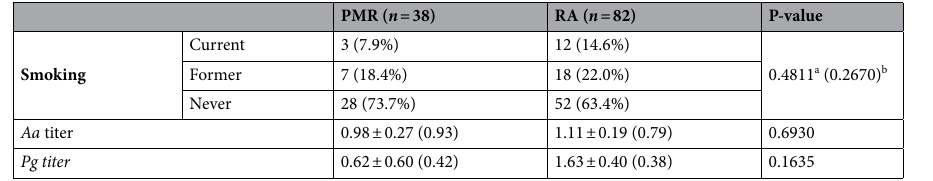
Table 2. Serum IgG antibody titers of patients with PMR and RA. Data are expressed as means ± SE (median). Aa Aggregatibacter actinomycetemcomitans , IgG immunoglobulin G, Pg Porphyromonas gingivalis , PMR polymyalgia rheumatic, RA rheumatoid arthritis, SE standard error. There were no significant differences in antibody titers between the PMR and RA groups. Effect of smoking was tested using Fisher’s exact test for "a" and Pearson’s chi-square test for "b". a Comparison between each value (3 × 2 Fisher’s exact test). b Comparison between "current + former" vs "never.” (2 × 2 Pearson’s chi-square test).